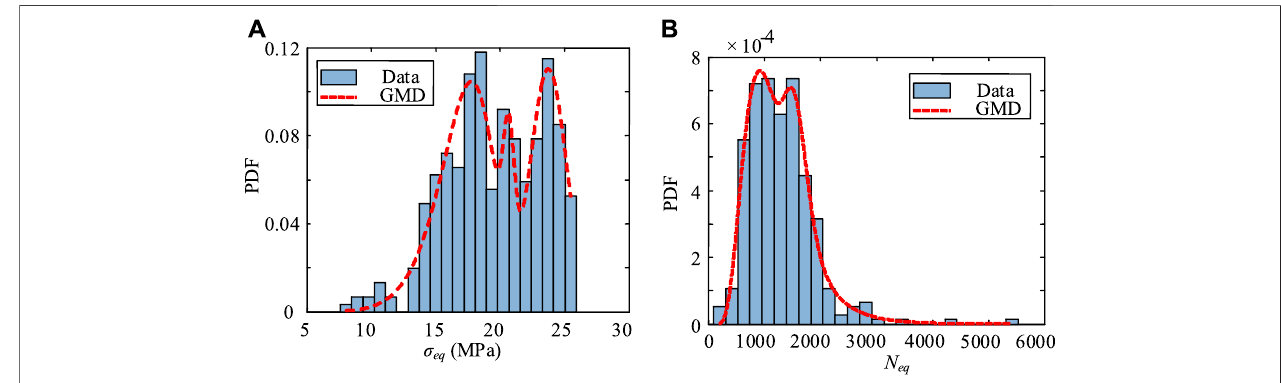
Frontiers in Materials |